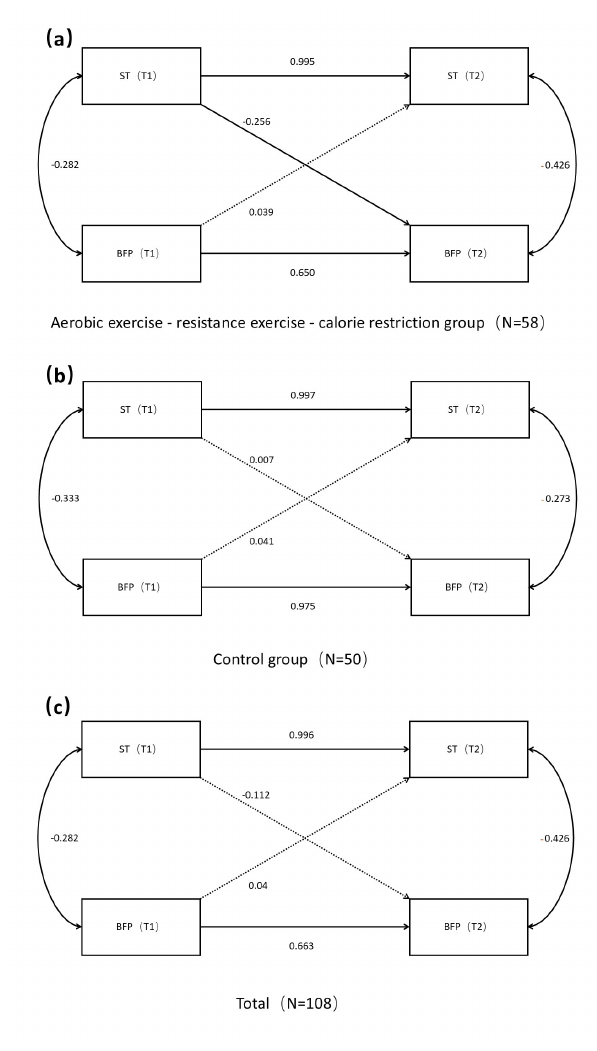
Fig. 1. Cross-lagged model. (a) model for the intervention group, (b) model for the control group, and (c) model for the overall; dashed lines indicate p > 0.05, solid lines indicate p < 0.05; one- way arrows are labeled with β and two-way arrows are labeled with correlation coefficients. ST, salivary testosterone; BFP, body fat percentage; T1 = June 8, 2020, T2 = August 31,